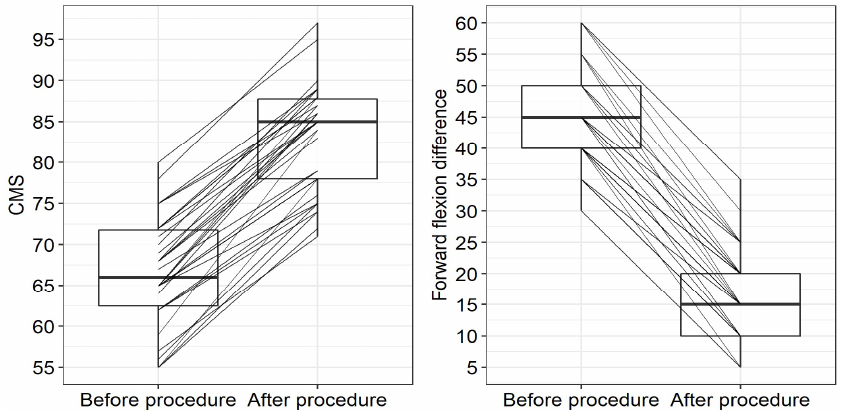
Figure 3. Constant–Murley score (CMS)—( left )—and forward flexion difference—( right )—between the individual patients’ conditions before and after the arthroscopic arthrolysis and osteosynthetic material extraction—boxplots including paired results of individual patients; please note that while positive change signifies an improvement in CMS, negative change indicates improvement in the parameter “Forward flexion difference between shoulders”.